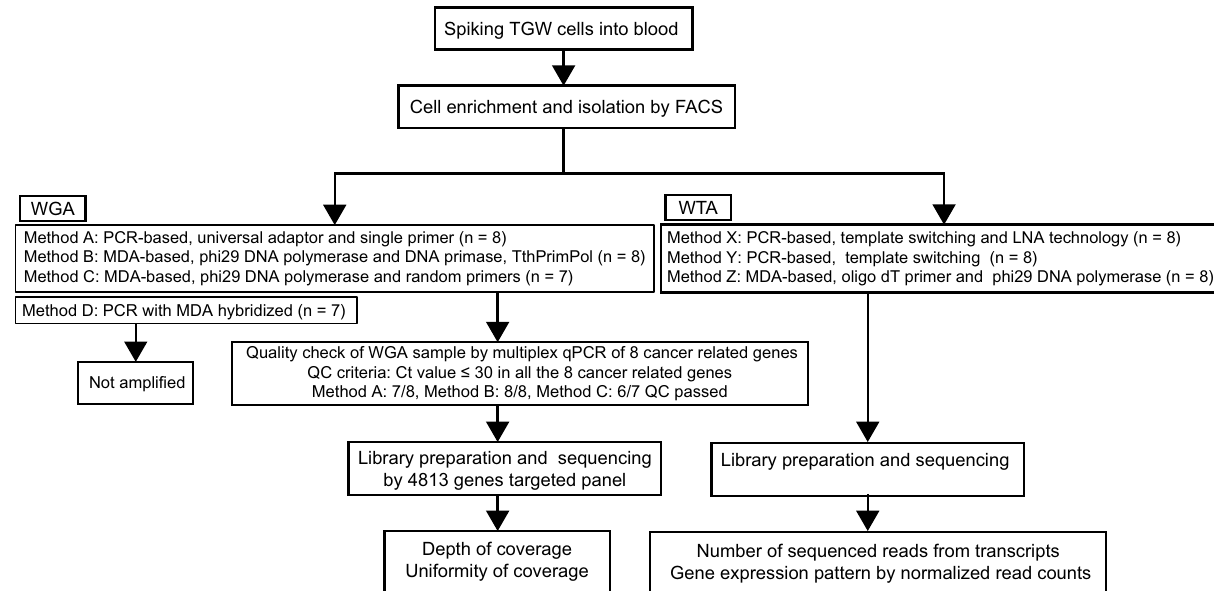
Figure 1. Experimental design. TGW neuroblastoma cells were spiked into blood derived from a healthy volunteer and isolated by fluorescence-activated cell sorting (FACS) using anti-GD2 and CD90 antibodies. We amplified DNA and mRNA from isolated single TGW cells using several different WGA and WTA methods. We performed a quality check (QC) of the WGA samples by multiplex qPCR of eight cancer-related genes, and QC criteria was set as threshold cycles (Ct values) ≤ 30 in all the genes. Next, we performed single-cell sequencing and evaluated the depth and uniformity of coverage for WGA samples, the number of sequenced reads from transcripts and gene expression patterns for WTA samples. FACS fluorescence-activated cell sorting, WGA whole-genome amplification, WTA whole-transcriptome amplification, PCR polymerase chain reaction, MDA multiple displacement amplification, LNA locked nucleic acid